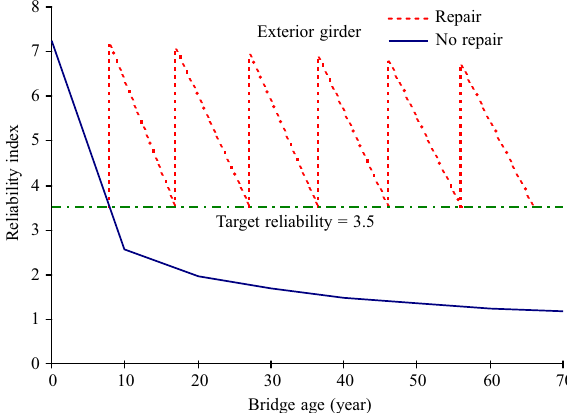
Fig. 7. Variation in the reliability of the interior girder of the bridge with age